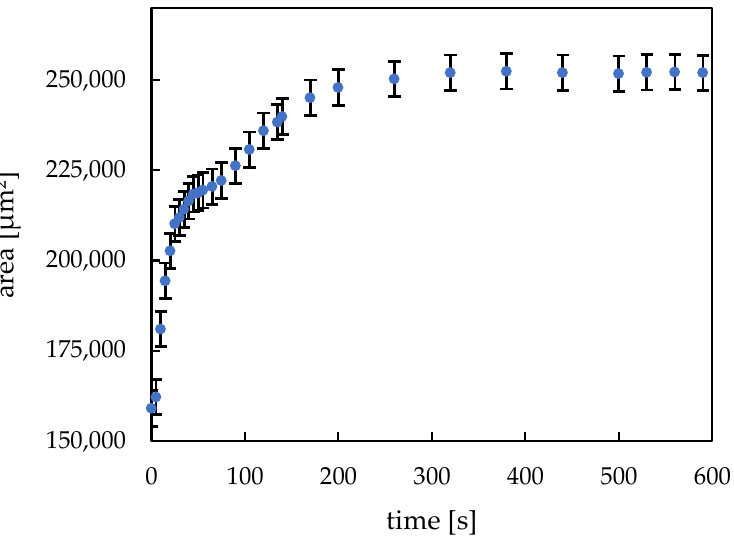
Figure 10. Free swelling of hydrogels (60 s UV exposure time, 400 droplets, ca. 450 pl per drop). The average hydrogel area results from three swelling kinetic measurements.